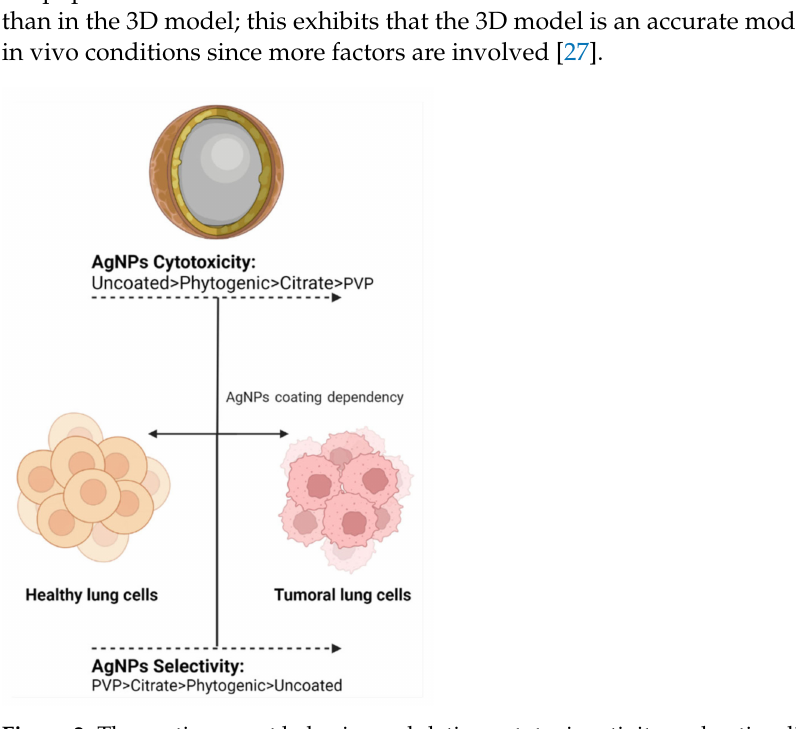
Figure 2. The coating agent helps in modulating cytotoxic activity and antiproliferative selectivity. The image shows the trend observed for the most frequently used coating agents in